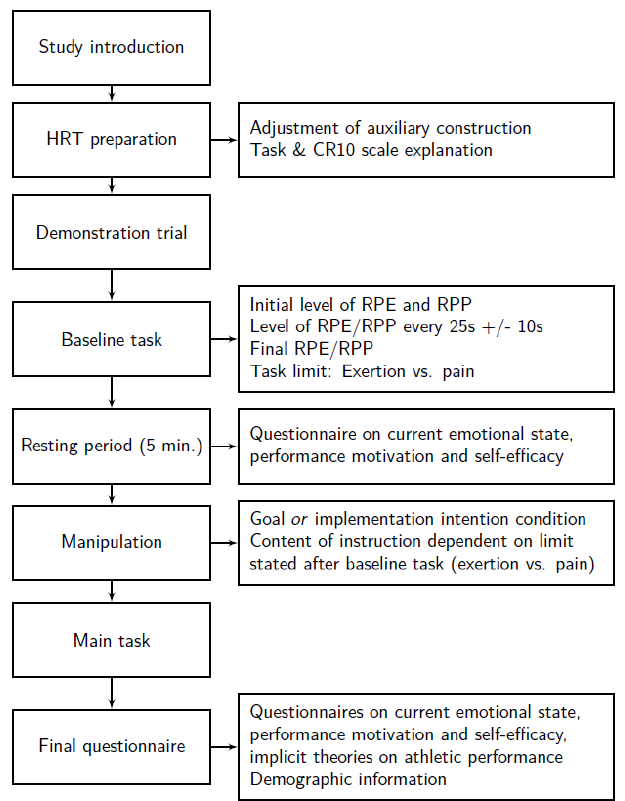
Figure A1. Flowchart of the study procedure. The procedure of the baseline task and the main task was analogous. Table A1. Linear regression model for explaining errors in the main task in the HRT. The intercept represents the expected mean value of errors in the main task when all other predictors are equal to 0. Numbers in parentheses are robust standard errors. Baseline: Condition = Goal Intention, Limit (reason for baseline task termination) = Exertion .